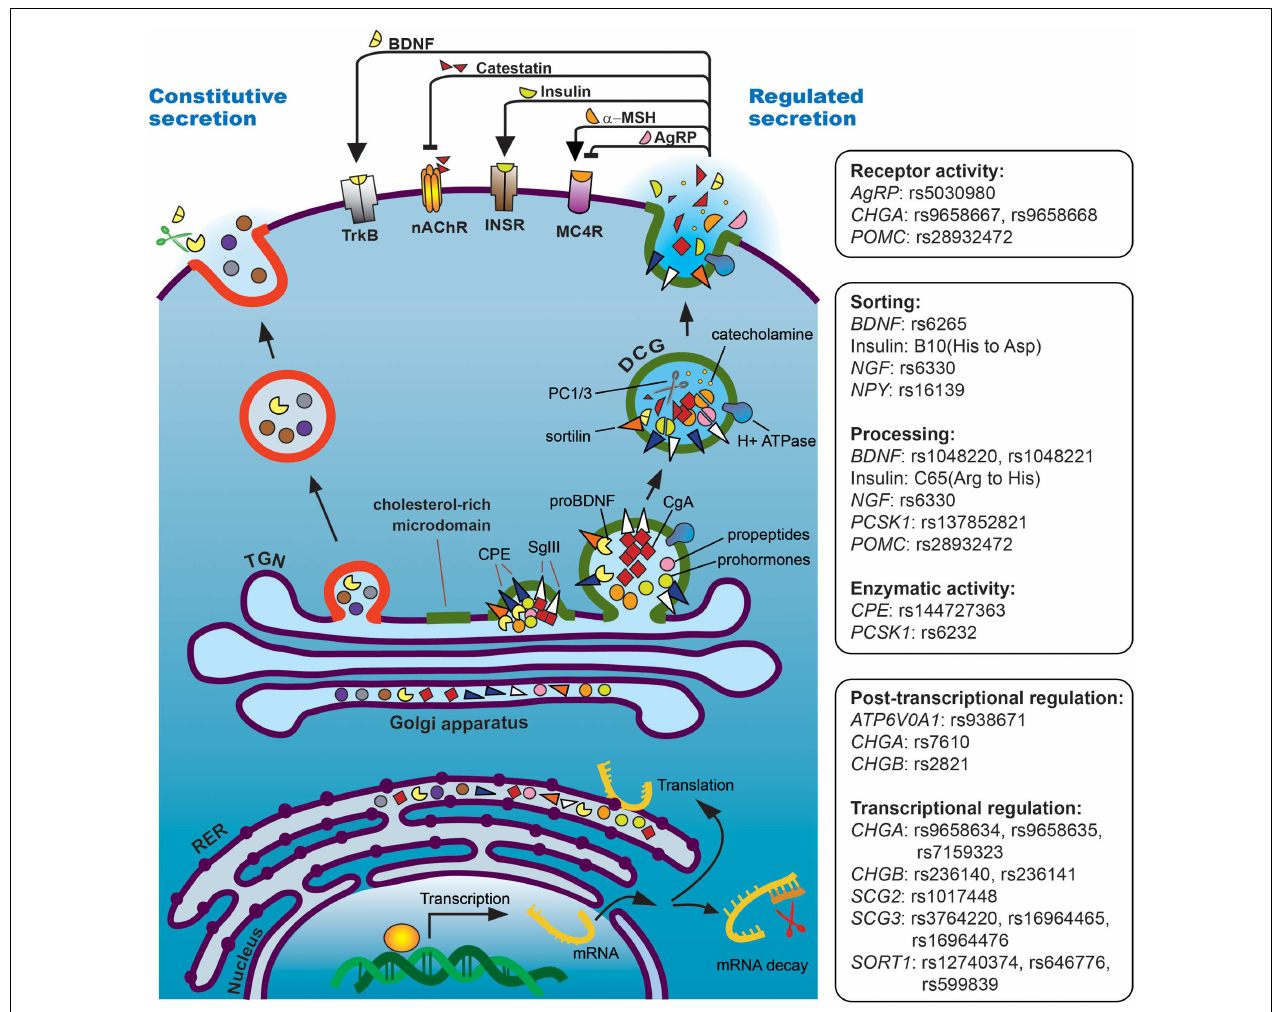
SNPs in convertase/peptidase catalytic or regulatory domains reduce enzymatic activity and lead to aberrant propeptide processing, (4) SNPs in the signal peptide and/or sorting domain(s) disrupt regulated secretion, and (5) SNPs that change the processing or sequence of neuropeptides modulate membrane receptor binding affinity.TrkB, tropomyosin-related kinase B receptor; INSR, insulin